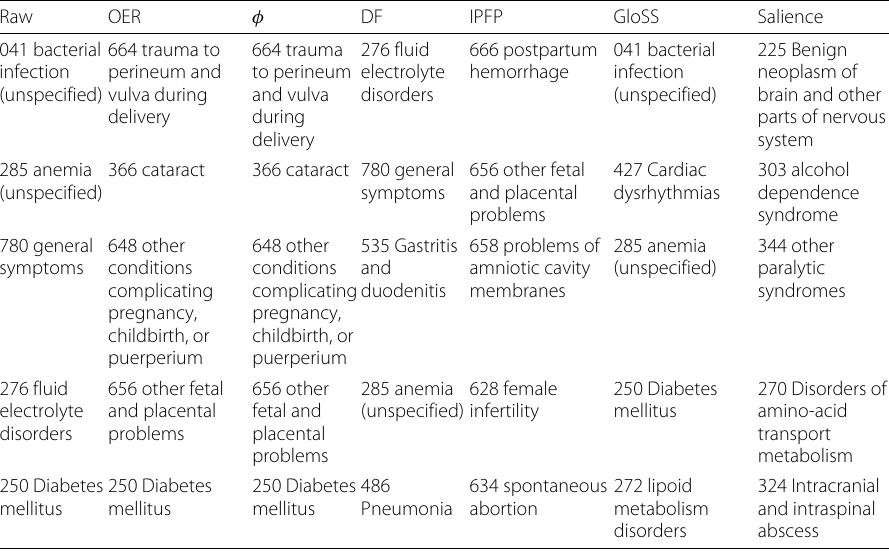
Table 10 Top 5 diseases with highest hub-ness scores in different networks, according to the HITS algorithm